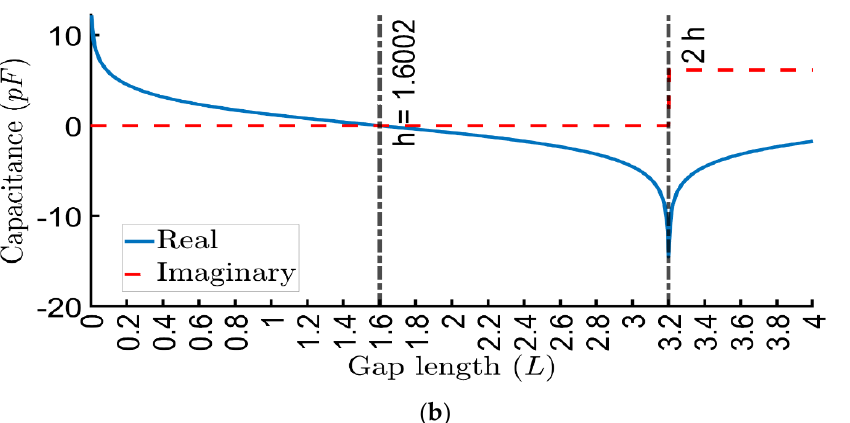
Figure 3. The gap dimension effect on the capacity: ( a ) Capacity in terms of gap length and substrate thickness ( L , h ); ( b ) Capacity vs. gap length when substrate thickness h = 1.6002 mm.